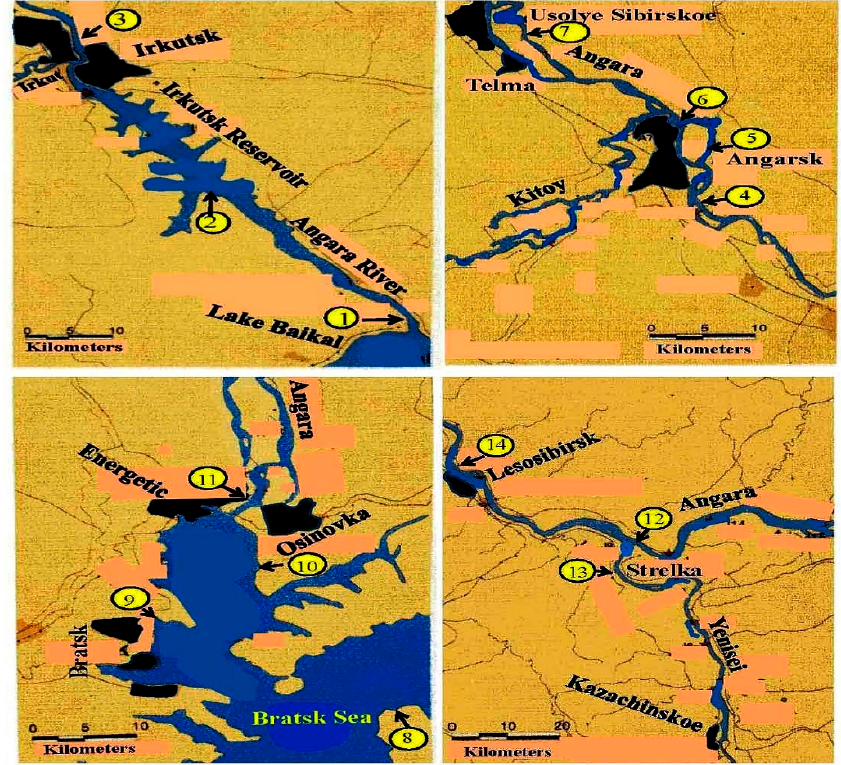
Figure 2. Fragments of the Angara/Yenisei River system and locations of spectral optical measure- ments and water sampling at a distance from Lake Baikal to Lesosibirsk.